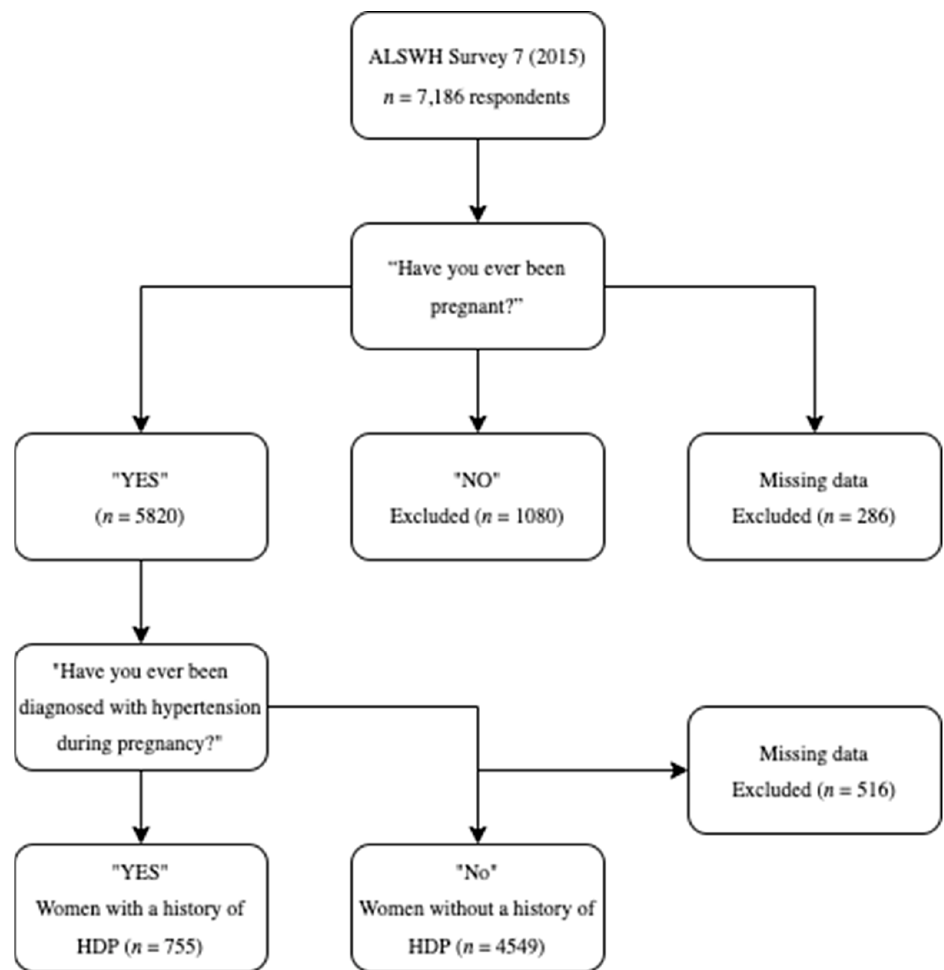
Figure 1. Summary of selection of the participants included in the analysis.